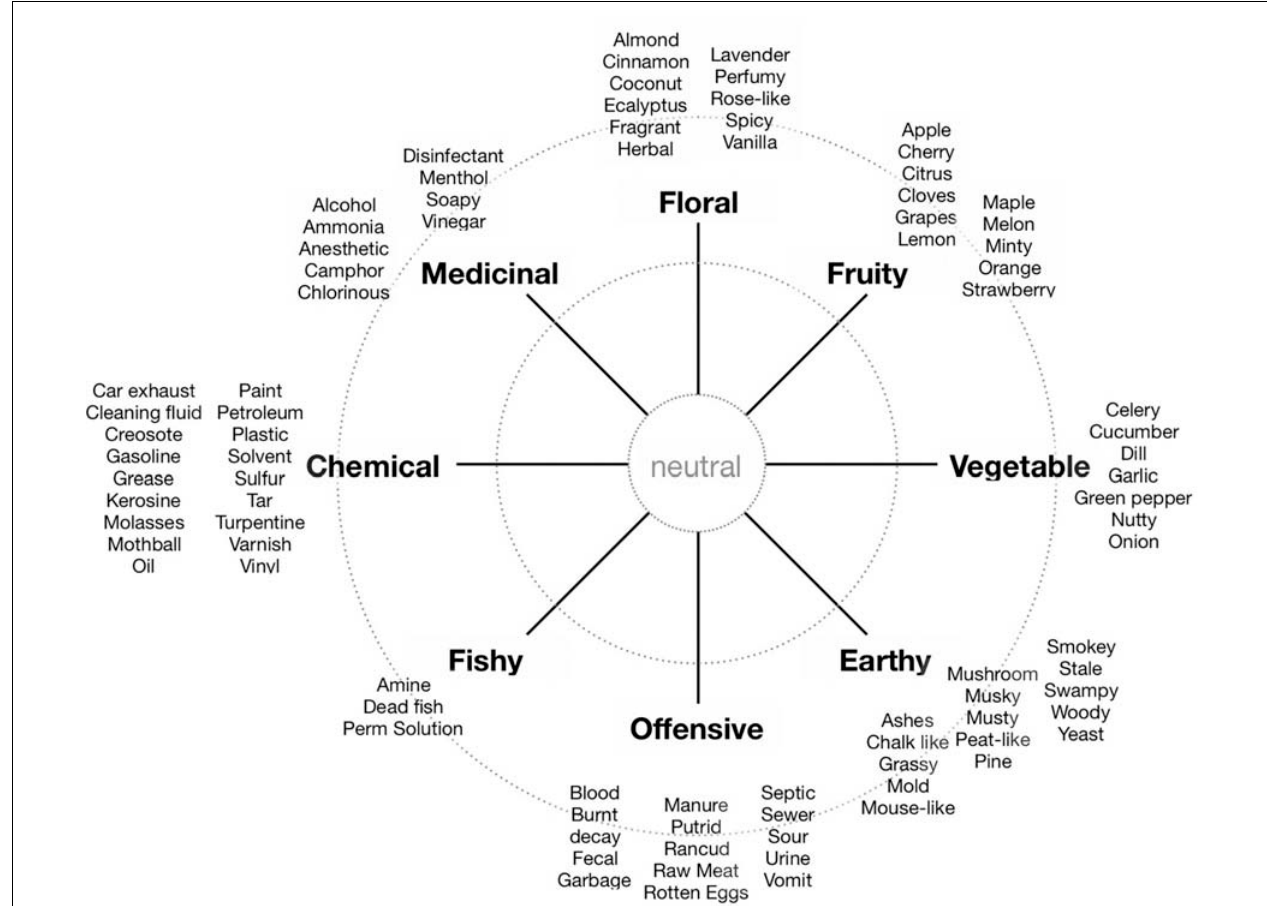
FIGURE 3 | The ‘smellwheel’ used in the present study (adapted from McGinley and McGinley,